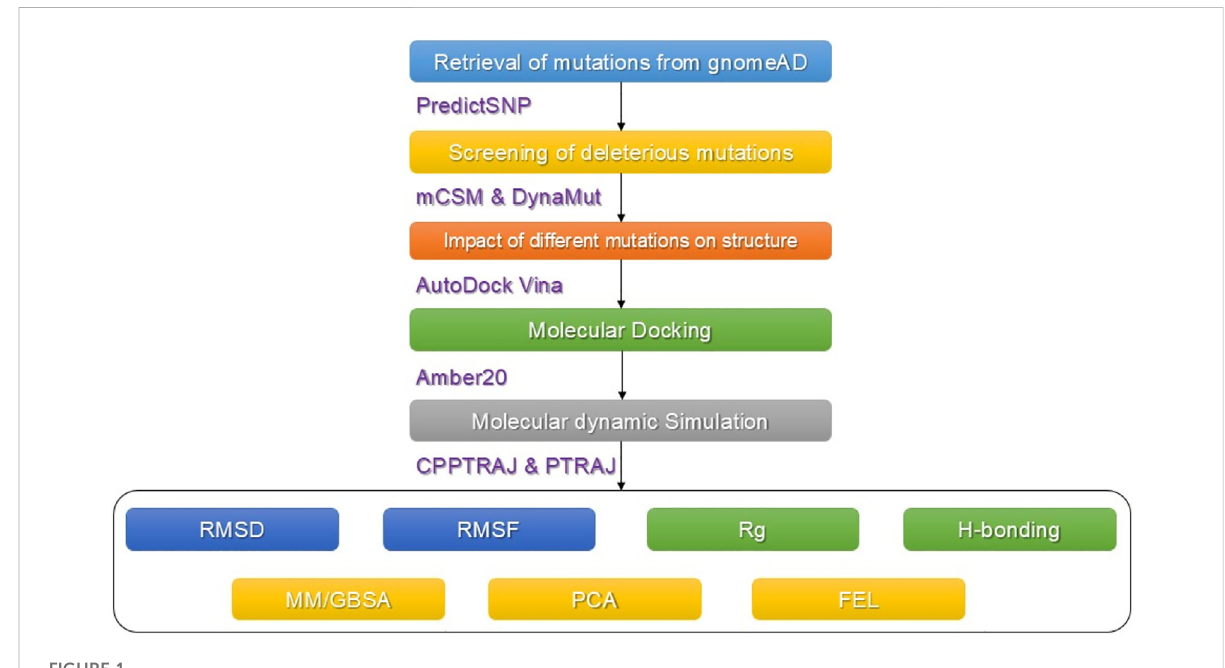
FIGURE 1 Methodological work fl ow of the work. Each tool used in each step is also